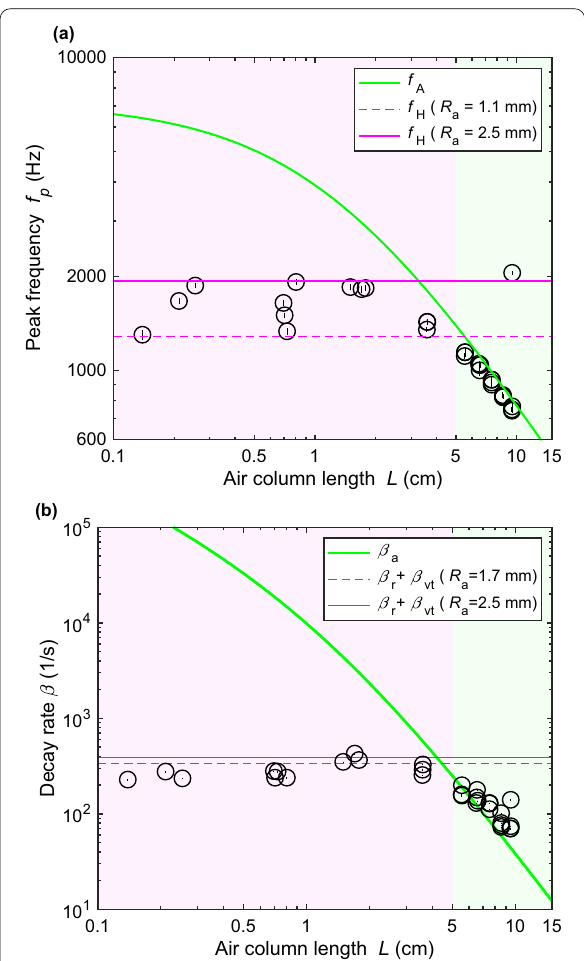
Fig. 16 Peak frequency f p , decay rate β (both with errors) vs. air column length L . a f p vs. L of airwaves excited by a V = 5 cm 3 bubble bursting in a suspension of φ = 0.4 . A green curve indicates f A (Eq. (20)). Pink lines indicate f H (Eq. (11)) calculated using R a values given in the legend. b β vs. L ; otherwise the same as ( a ). A green curve indicates the decay rate β a (Eq. (21)). Pink lines indicate β r + β vt (Eqs. (13), (14)) calculated using R a values given in the legend. R a is chosen to calculate the minimum and maximum values of β r + β vt in the range of R a = 1.1 − 2.5 mm used in ( a